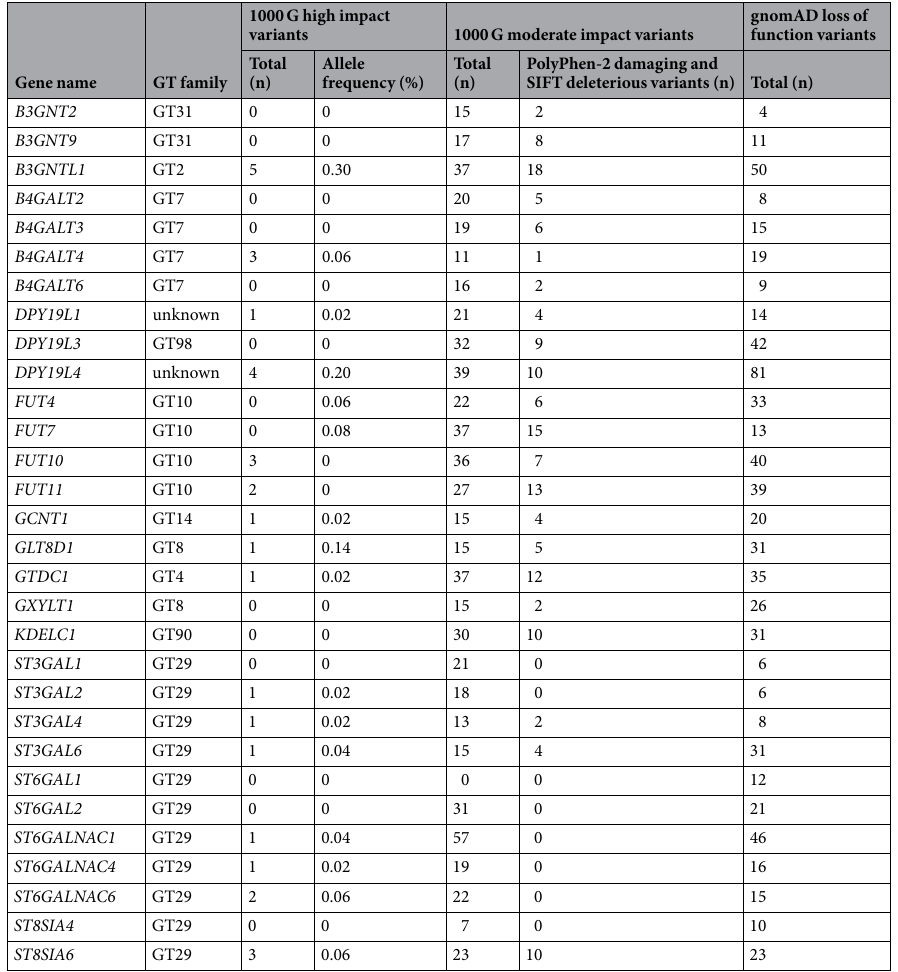
Table 2. Candidate GT genes expressed in RBCs with a benign predicted